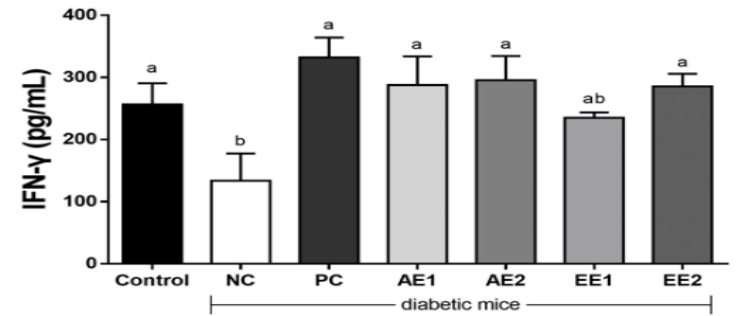
Figure 9. Effects of A. hookeri extracts on NK activity in the blood of diabetic mice. Control: non- diabetic mice; NC: negative control; PC: positive control, metformin 150 mg/kg BW; AE1: aqueous extract 100 mg/kg BW; AE2: aqueous extract 200 mg/kg BW; EE1: ethanol extract 100 mg/kg BW; EE2: ethanol extract 200 mg/kg BW. AE and EE groups were treated with A. hookeri extracts for 8